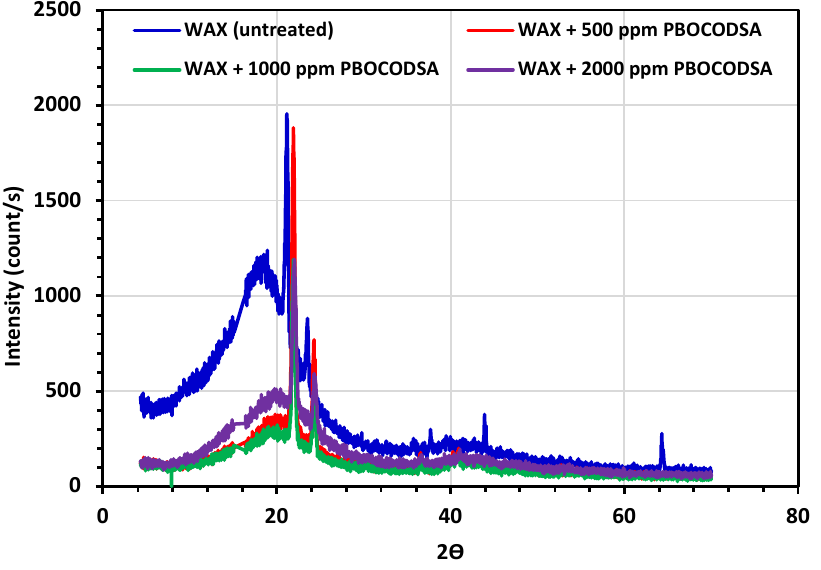
Figure 7. XRD of untreated paraffin wax from crude oil and its corresponding treatment with PBOCODSA.